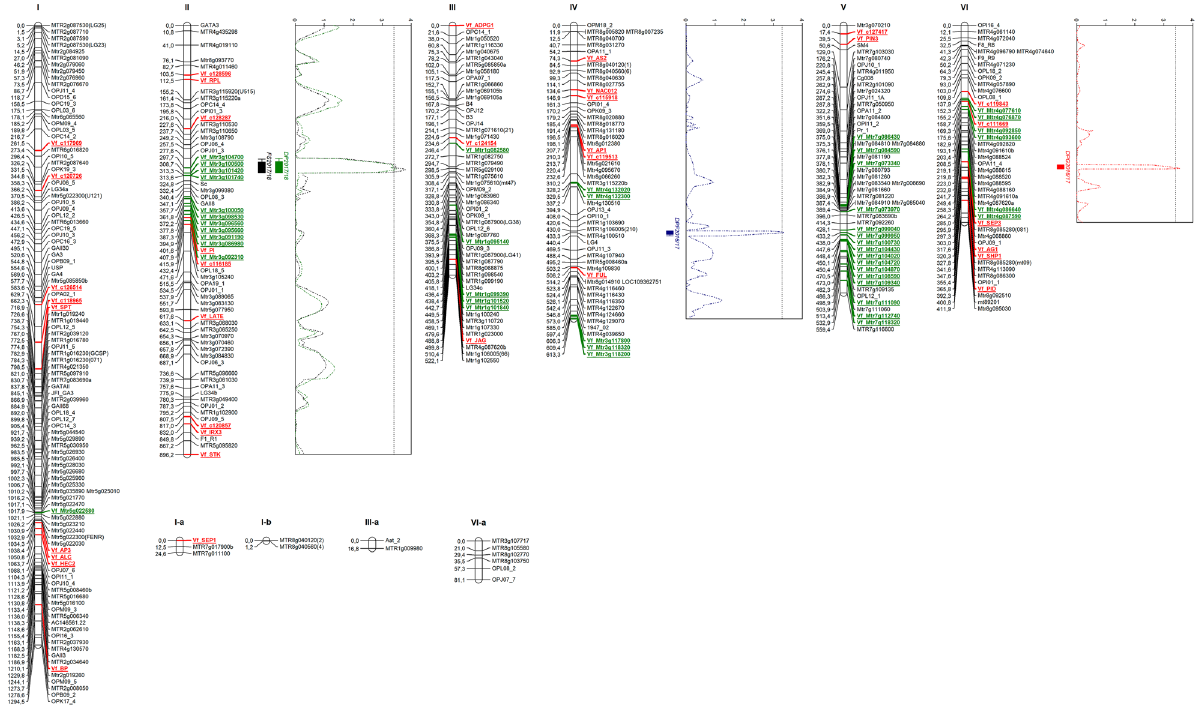
Figure 3. Linkage map and QTLs for dehiscence traits detected in the Vf6 x Vf27 RIL population. QTL locations are represented with bars (2-LOD interval) and boxes (1-LOD interval). Candidate gene markers are in red. Molecular markers used for map saturation by the Kompetitive Allele Specific PCR (KASP) assay are in green. FS, Fissured pods; DPG, Dehiscent pods in the greenhouse; DPF; Dehiscent pods in the field.